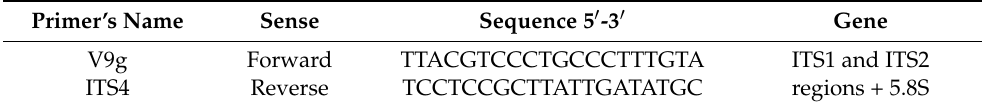
Table 2. Primers used for PCR amplification for fungal